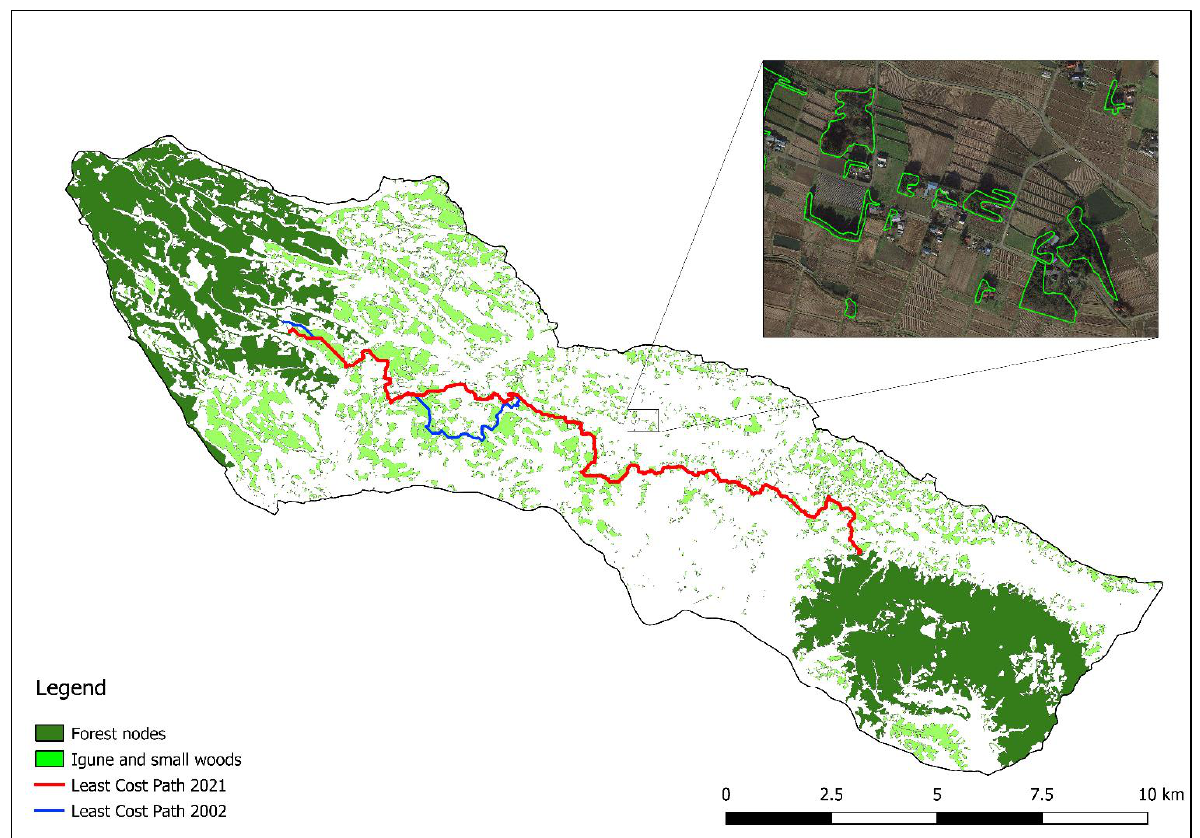
Figure 2. A high number of igune and other small woods are found around farmhouses or interspersed with paddy fields between the two forest nodes located in the north-west and south-east part of the study area.